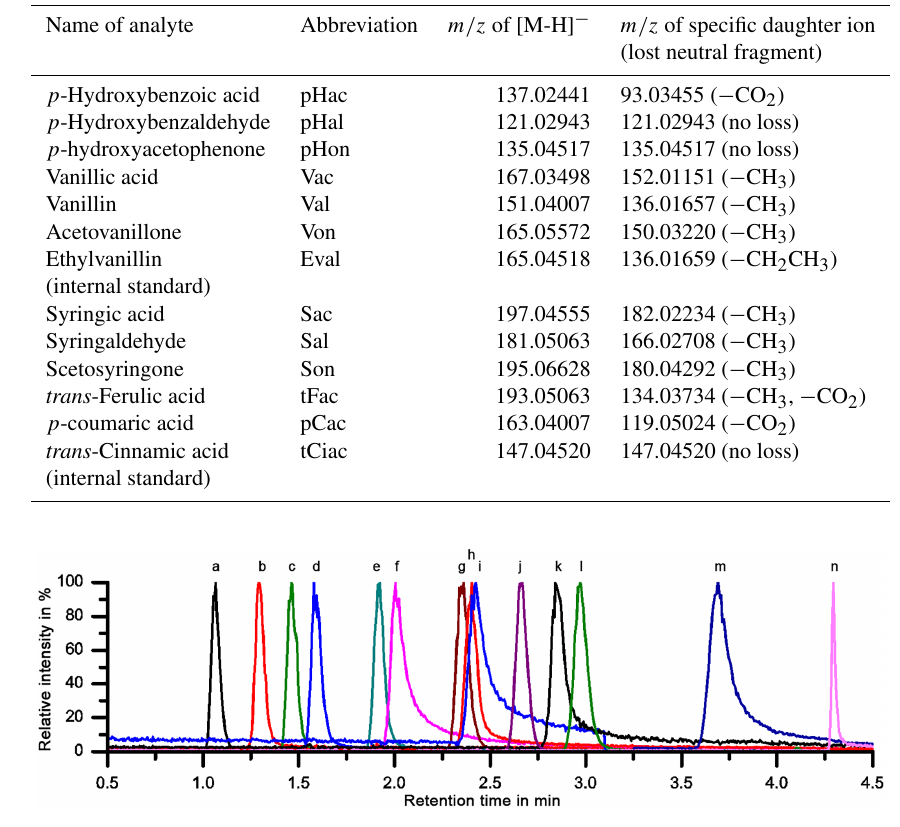
Figure 2. Normalized chromatogram of 14 LOP standards on a PFP column. Explanation of the peak numbers (for abbreviations see Table 1): a: pHac, b: Vac, c: Sac, d: pHal, e: pHon, f: Val, g: pCac, h: Sal, i: Von, j: cFac, k: Son, l: tFac, m: Eval, n: tCiac.